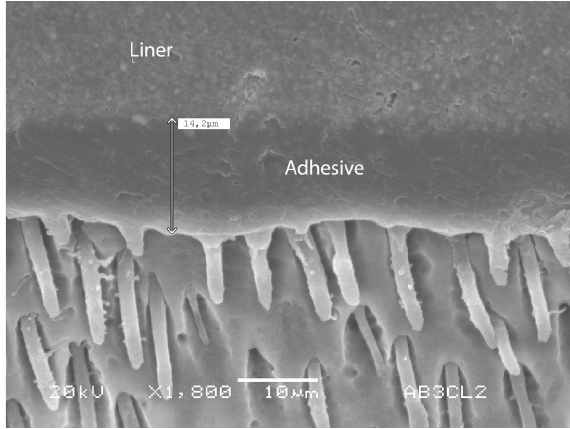
Figure 4- A hydrophobic coat (liner) can been used on the top of the hydrophilic primed dentin in some adhesive systems, such as All Bond